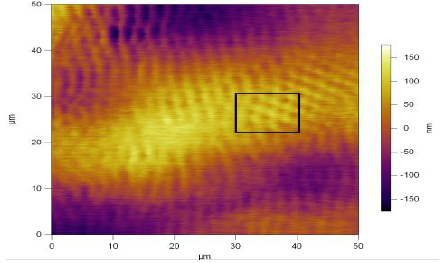
Figure 1: 50  m x 50  m section of articular cartilage surface